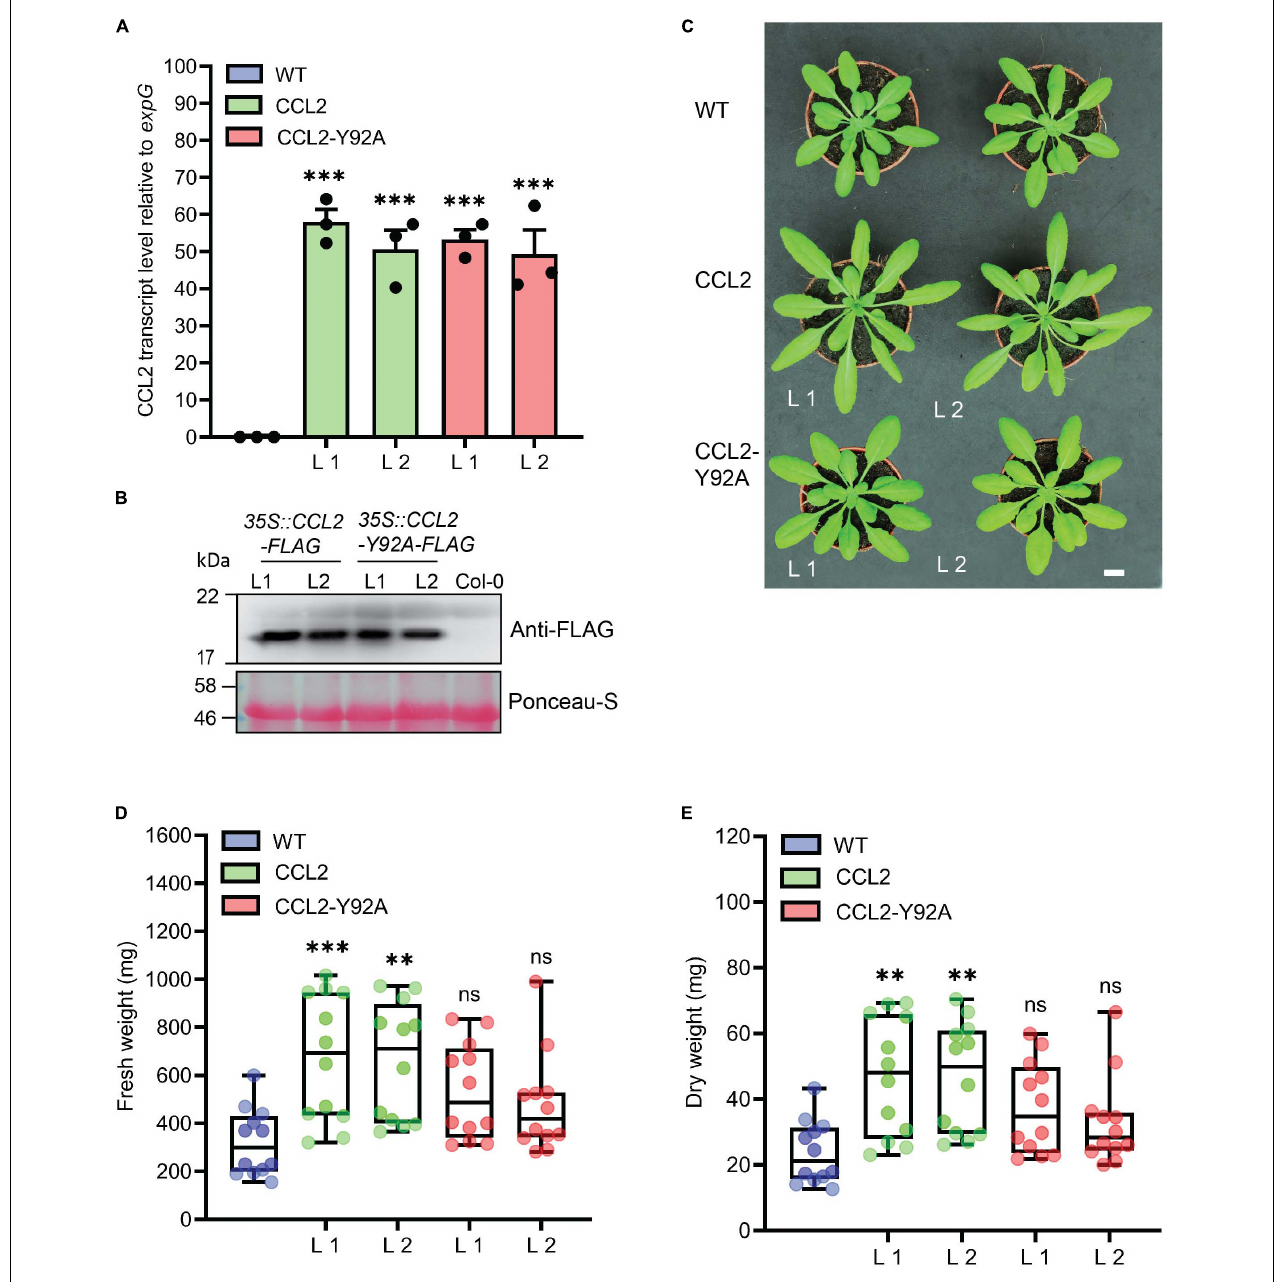
FIGURE 1 | Characterization of CCL2-expressing Arabidopsis lines. (A) qPCR analysis of relative CCL2 and CCL2-Y92A transcript levels in 4-week-old plants. Transcript levels were normalized to expG gene (AT4G26410). Mean values ± SE of three independent experiments. (B) Immunoblot visualizing the expression level of CCL2 and CCL2-Y92A proteins. FLAG-tagged proteins were detected with anti-FLAG antibodies. Ponceau-S stained Rubisco large subunit served as loading control. Size bar = 1 cm (C) Growth phenotype of transgenic lines compared to WT. Two independent lines (L1 and L2) are shown for each construct. (D) Fresh weight (FW) and (E) dry weight (DW) of shoots of 4-week-old plants ( n = 12; three independent experiments). Boxplots represent median and 1.5 times the interquartile range. Asterisks show significant differences between transgenic lines compared to the WT ( ∗∗∗ P ≤ 0.001, ∗∗ P ≤ 0.01) determined by one-way ANOVA followed by post hoc analysis with Dunnett’s multiple-comparison